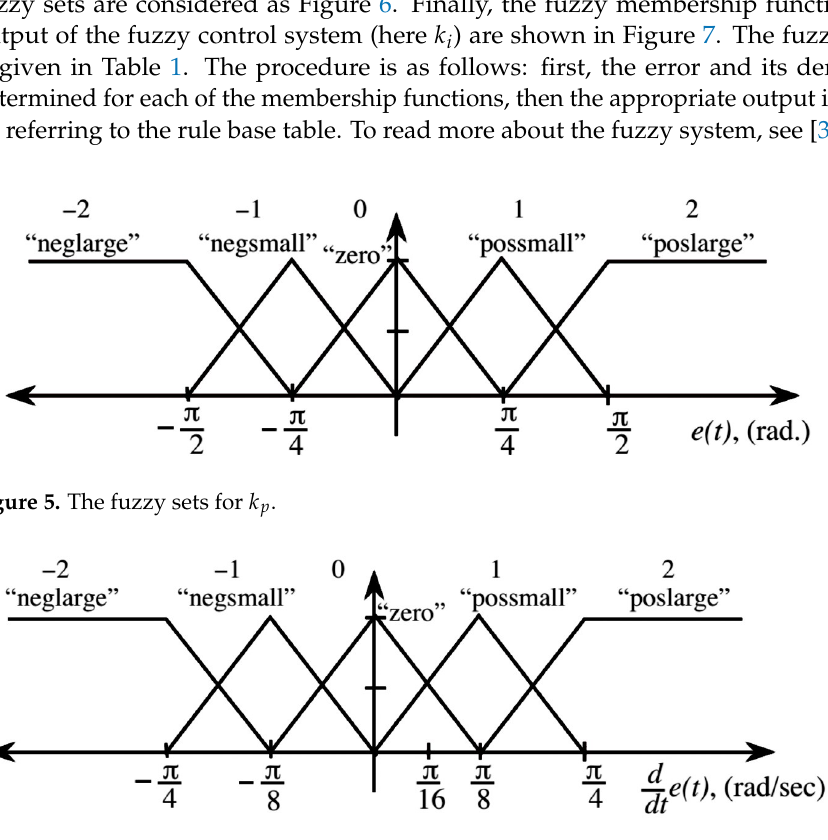
Figure 6. The fuzzy sets for k d